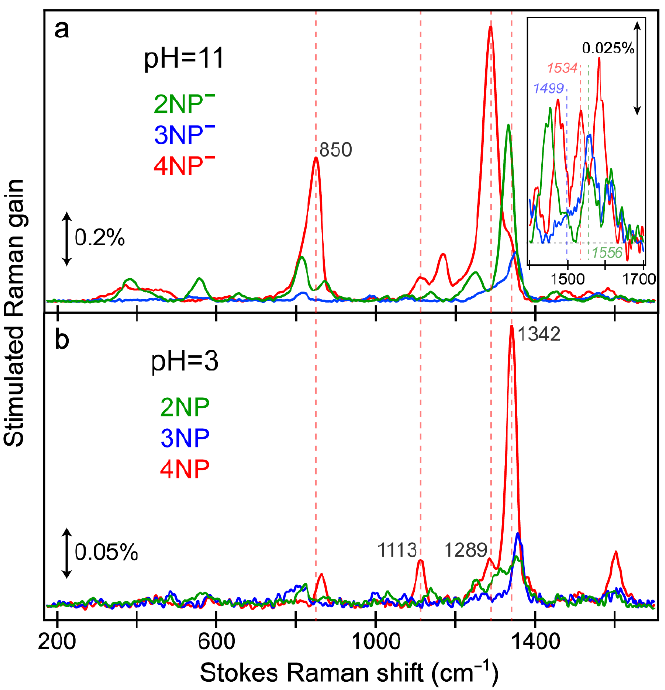
Figure 8. Ground-state FSRS spectra of various nitrophenolates and nitrophenols in water. ( a ) FSRS spectra of 2NP − (green), 3NP − (blue), and 4NP − (red) are overlaid. The stimulated Raman gain magnitude of 0.2% is denoted by the double-arrowed line. The high-frequency region above 1400 cm –1 is enlarged and shown in the inset on the right side, with color-coded vertical dashed lines denoting the C=O stretching modes in three nitrophenolates, as aided by quantum calculations (see Figures S9 and S11). ( b ) FSRS spectra of 2NP (green), 3NP (blue), and 4NP (red) are overlaid. The stimulated Raman gain magnitude of 0.05% is denoted by a double-arrowed line. Vertical red dashed lines highlight the peak frequency variation between the samples, with key frequencies labeled.